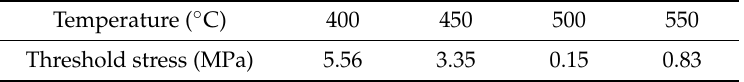
. Figure 9. Variation of the flow stress as a function of ε  1/2 for the fine-grained 5A70 alloy subjected Figure 9. Variation of the flow stress as a function of ε 1/2 for the fine-grained 5A70 alloy subjected to RHT. to RHT. Table 2. Threshold stress of RHT 5A70 alloy at the studied Table 2. Threshold stress of RHT 5A70 alloy at the studied temperatures.